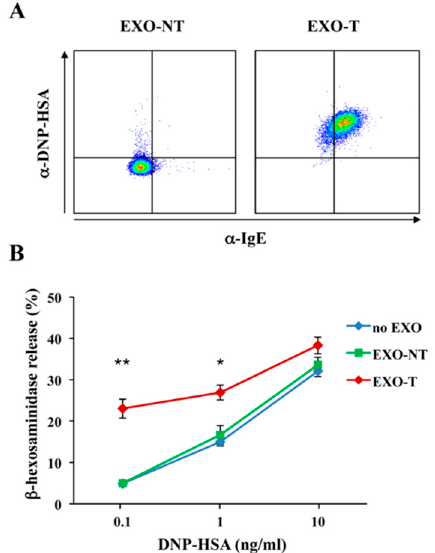
Figure 2. Mast cell (MC)-derived exosomes endowed with IgE and antigens cooperate with a soluble antigen to induce MC degranulation. ( A ) RBL-2H3 cells were sensitized with 1 µ g / mL IgE (clone SPE-7) ON at 37 ◦ C and then stimulated or not with 1 µ g / mL DNP-HSA for 6 h. Exosomes (EXO) were purified by sequential ultracentrifugation from culture supernatants of unstimulated (EXO-NT) and stimulated (EXO-T) RBL cells, and then 4 µ g of EXO-NT and EXO-T were passively adsorbed on 4 µ m Aldehyde / Sulfate Latex Beads (Life Technologies, Carlsbad, CA, USA) ON at 4 ◦ C. Exosome / bead complexes were washed and labelled with AlexaFluor 488 anti-DNP (Life Technologies, Carlsbad, CA, USA) and BV-510 anti-IgE (BD biosciences). ( B ) RBL-2H3 cells were sensitized by the addition of IgE for 1 h at 37 ◦ C. IgE-loaded cells were then incubated with EXO-NT or EXO-T (20 µ g / mL) together with the indicated suboptimal doses of DNP-HSA. After 30 min, cell culture supernatants were collected and β -hexosaminidase release was measured as marker of degranulation. As the control, β -hexosaminidase was analysed in exosome lysates that resulted negative (data not shown). All data are presented as the mean ± SD of three independent experiments. * p < 0.05, ** p < 0.01, one-way ANOVA with Tukey’s multiple comparison test. The technique used to isolate exosomes has been fully described in